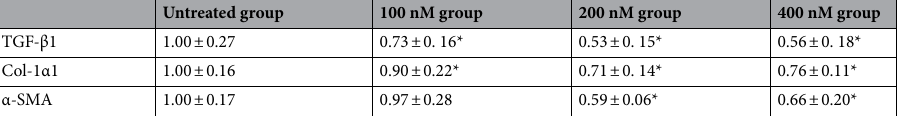
Table 2. Effects of calcitriol at different concentrations on the mRNA expression of TGF-β1, Col-1α1 and α-SMA in pHSC. *Compared with the untreated group, P < 0.05.